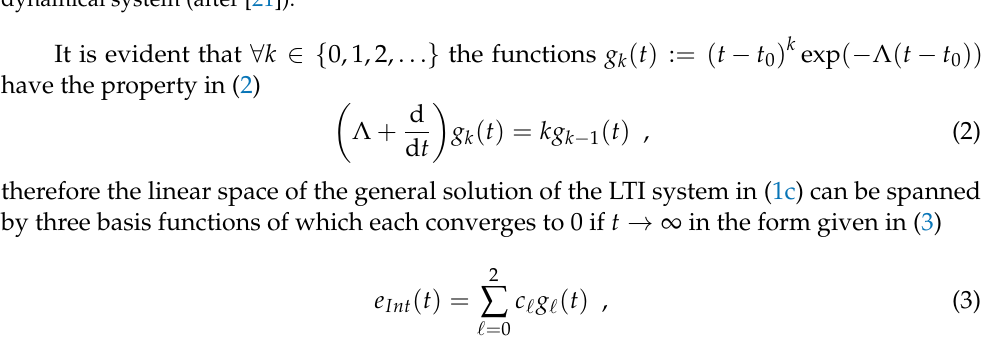
Figure 1. The structure of the fixed point iteration-based adaptive controller for a second-order dynamical system (after